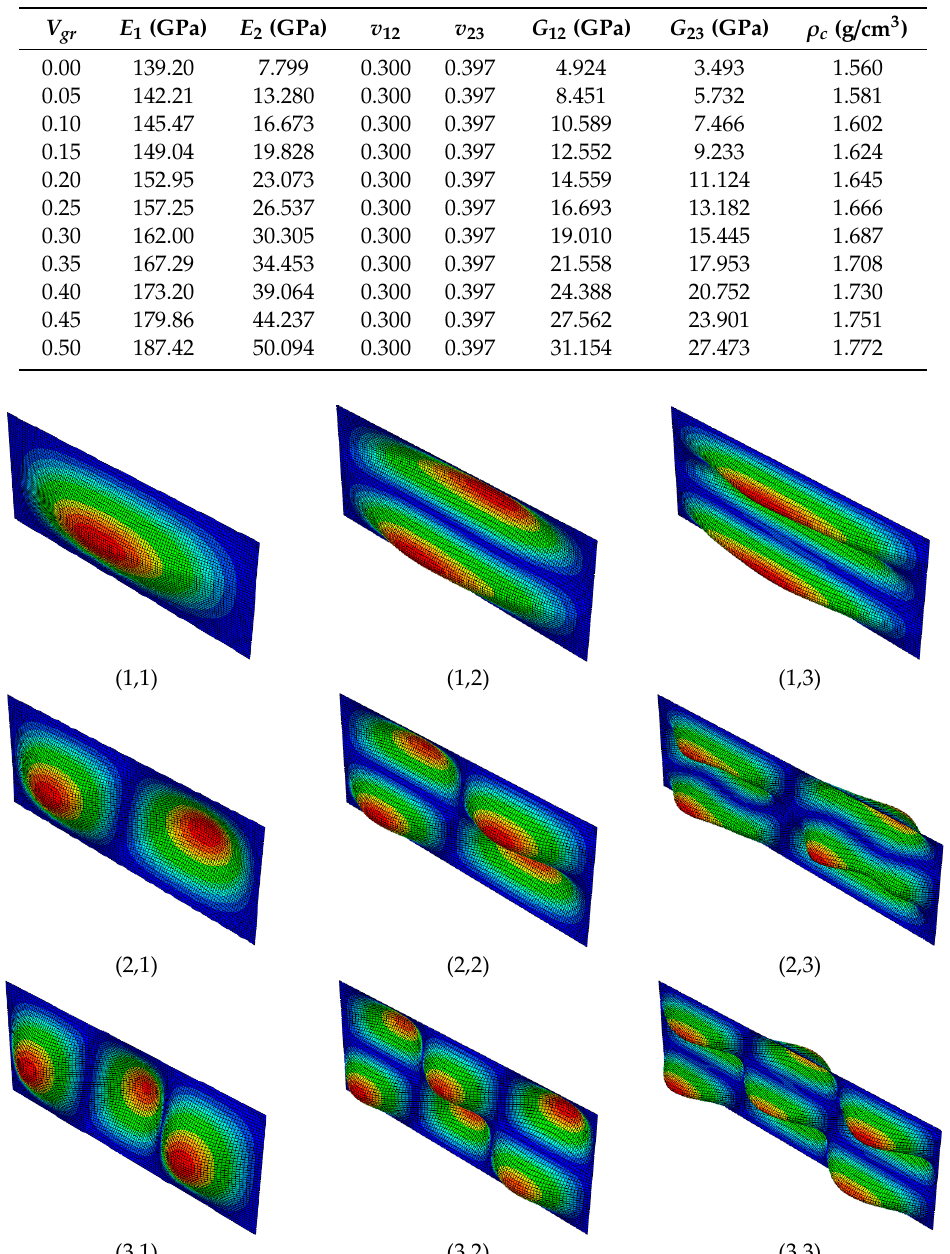
Table 3. Physical properties of components of the composite material.